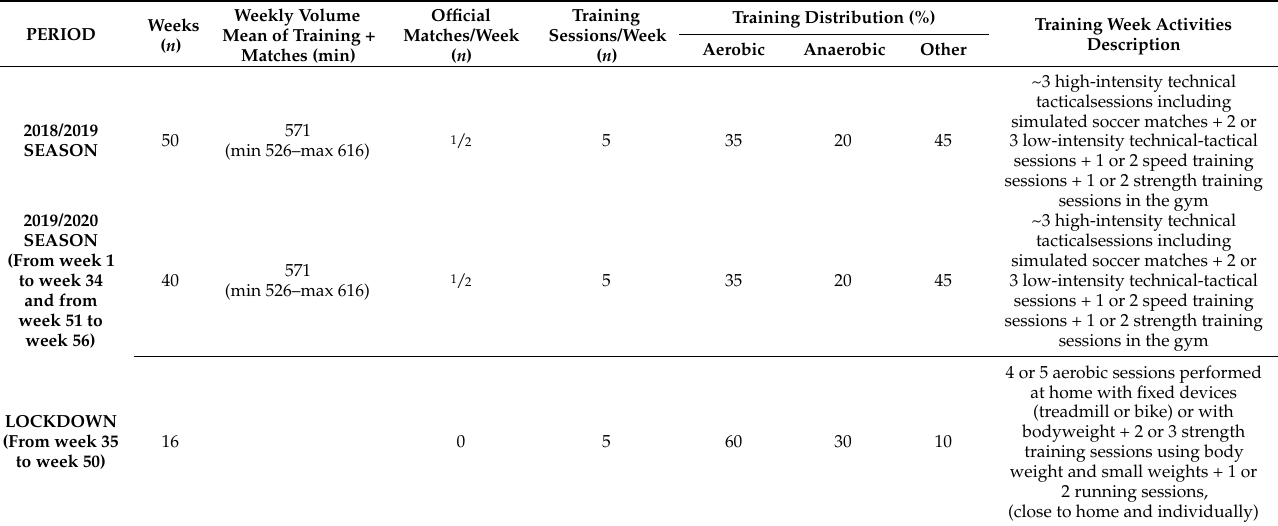
Table 1. Weekly training schedule, divided into 2018/2019 season, 2019/2020 season (COVID-19), and lockdown